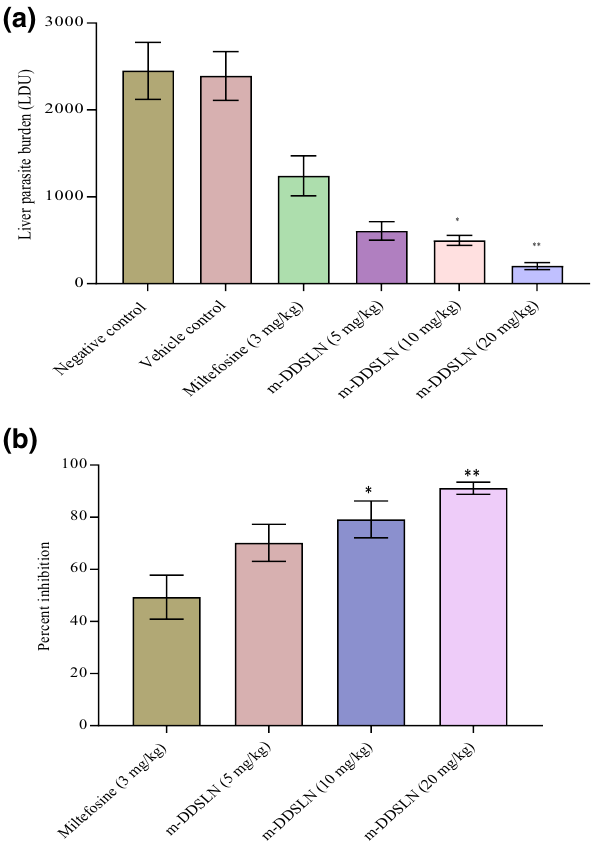
Figure 8. ( a ) In vivo anti-leishmanial activity of m-DDSLNs and miltefosine against L. donovani -infected BALB/c mice. DDSLNs (5–20 mg/kg) and miltefosine (3 mg/kg) were given orally to 7 days post infected mice for 5 consecutive days and day + 14, all the animals were sacrificed for parasitological observations. Results are presented as mean ± standard deviation (n = 4). ( b ) In vivo anti-leishmanial activity of m-DDSLNs and miltefosine against L. donovani -infected BALB/c mice. PI of m-DDSLNs (5–20 mg/kg) and miltefosine (3 mg/ kg) were calculated as compared to vehicle treated animals. All values were expressed as mean ± standard deviation (n =